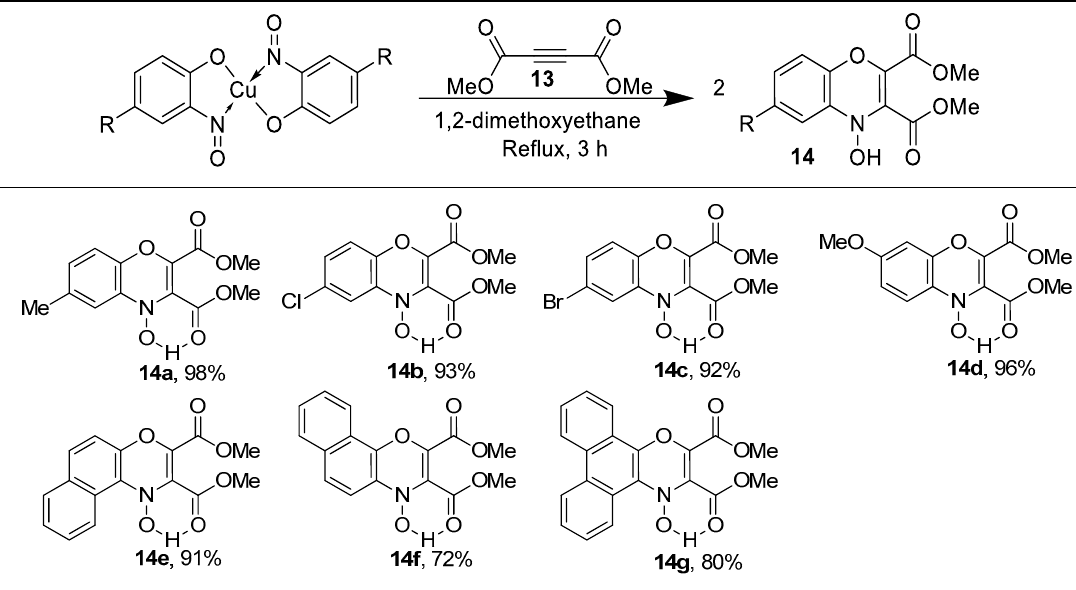
Table 5. The 2,4-cycloaddition procedure, with major products shown [76].